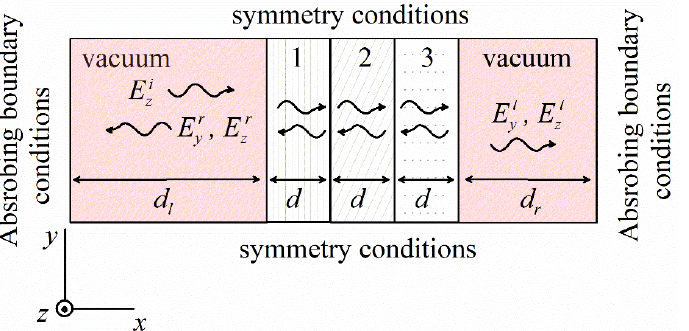
Figure 7. A z -polarized plane wave propagating in the x direction towards a three-layered carbon- fiber composite material, with anisotropic electrical conductivity behavior. The vacuum regions on the left and the right have dimensions large enough to separate incident from reflected fields. Symmetry conditions are applied at the y and z boundaries.